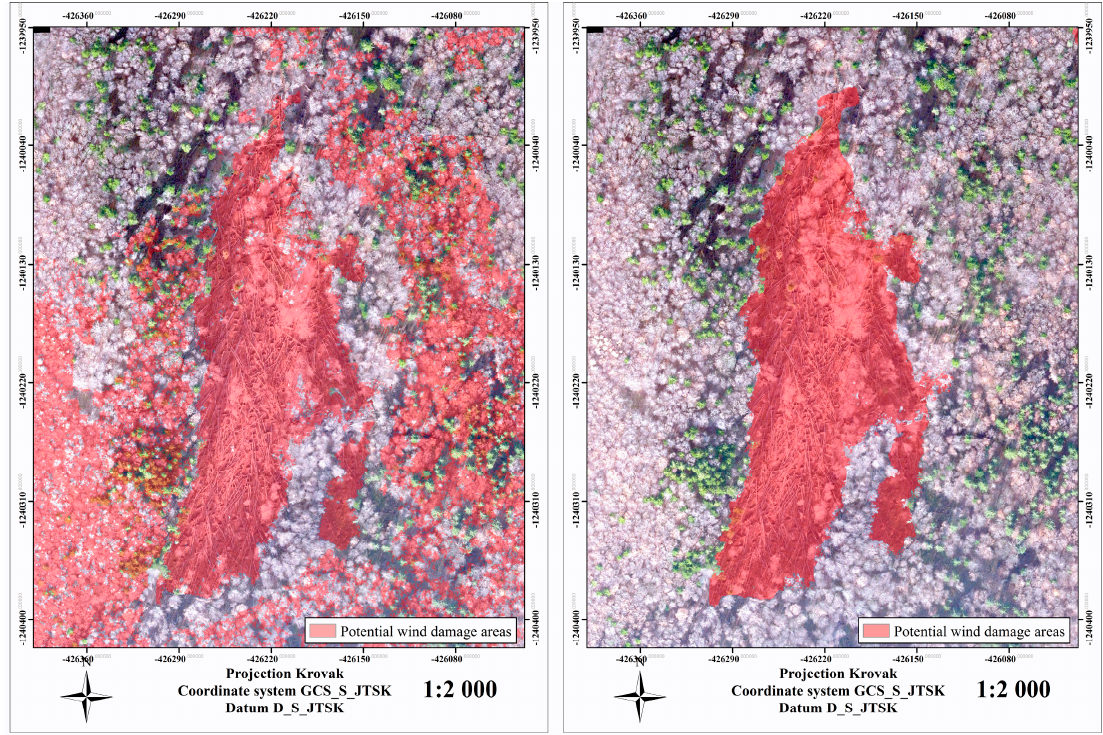
Figure 4. An example of the potential windthrow areas detected by the UAS method and UAS/ALS methods with emphasis on error 1B which is only present with the UAS method.